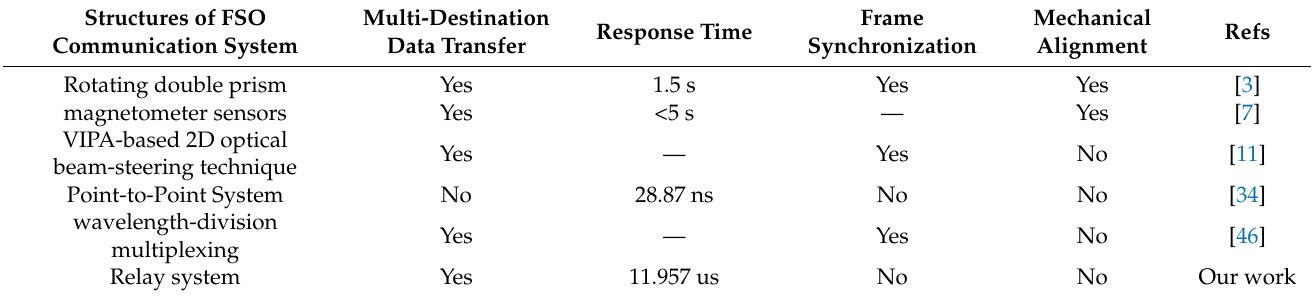
Table 3. Performance comparisons of the reported laser communication